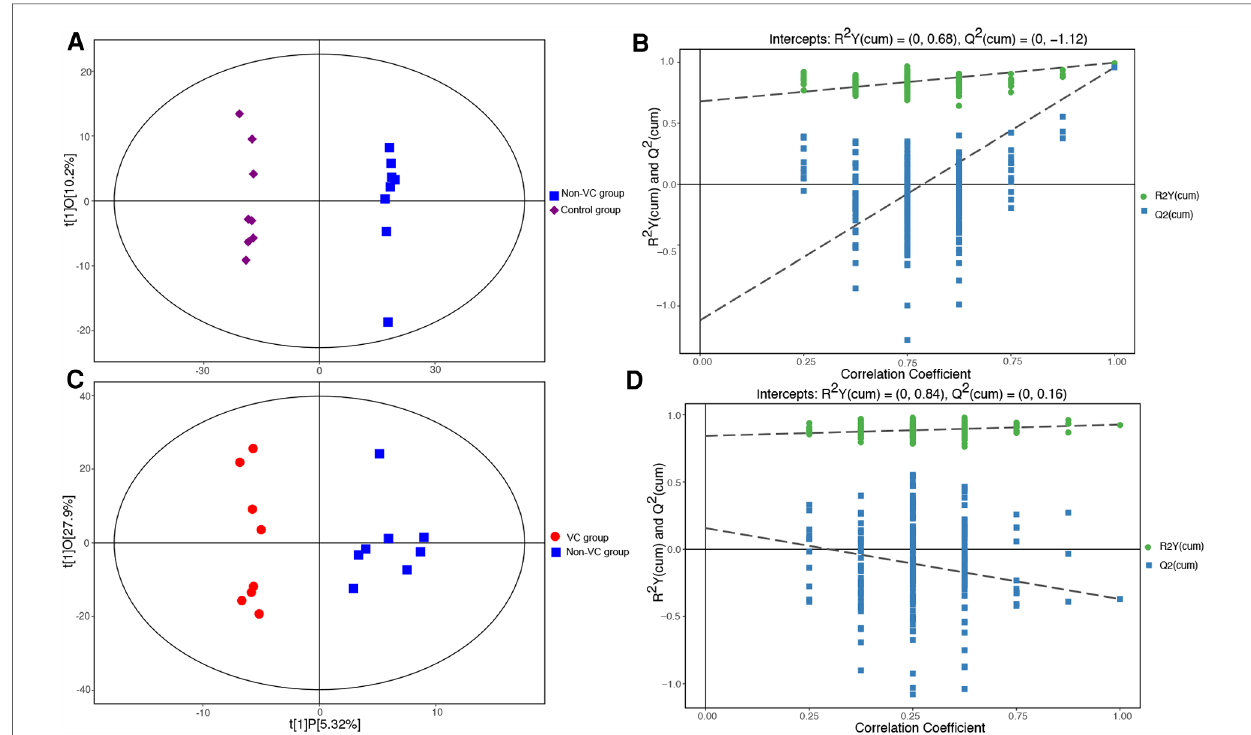
FIGURE 3 Scatter plots of the OPLS-DA scores. ( A ) Control group (purple diamonds) vs. the non-VC group (blue squares). ( B ) The permutation tests of the OPLS-DA models (control group vs. the non-VC group). ( C ) Non-VC group (blue squares) vs. the VC group (red dots). ( D ) The permutation tests of the OPLS-DA models (non-VC group vs. the VC group). The abscissa t [1] P -value represents the predicted principal component score of the fi rst principal component, while the ordinate t [1] O represents the orthogonal principal component score. The scatter patterns in the different groups could be separated clearly and all were within the 95% con fi dence interval (Hotelling ’ s T -squared ellipse). The retention of displacement of R2Y (green dots) was very close to 1. The Q2 (blue squares) of the original models was also very close to 1. The intercepts of the Q2 regression lines with the vertical axis were all <0, while the Q2 values were all lower than those of the original OPLS-DA models.